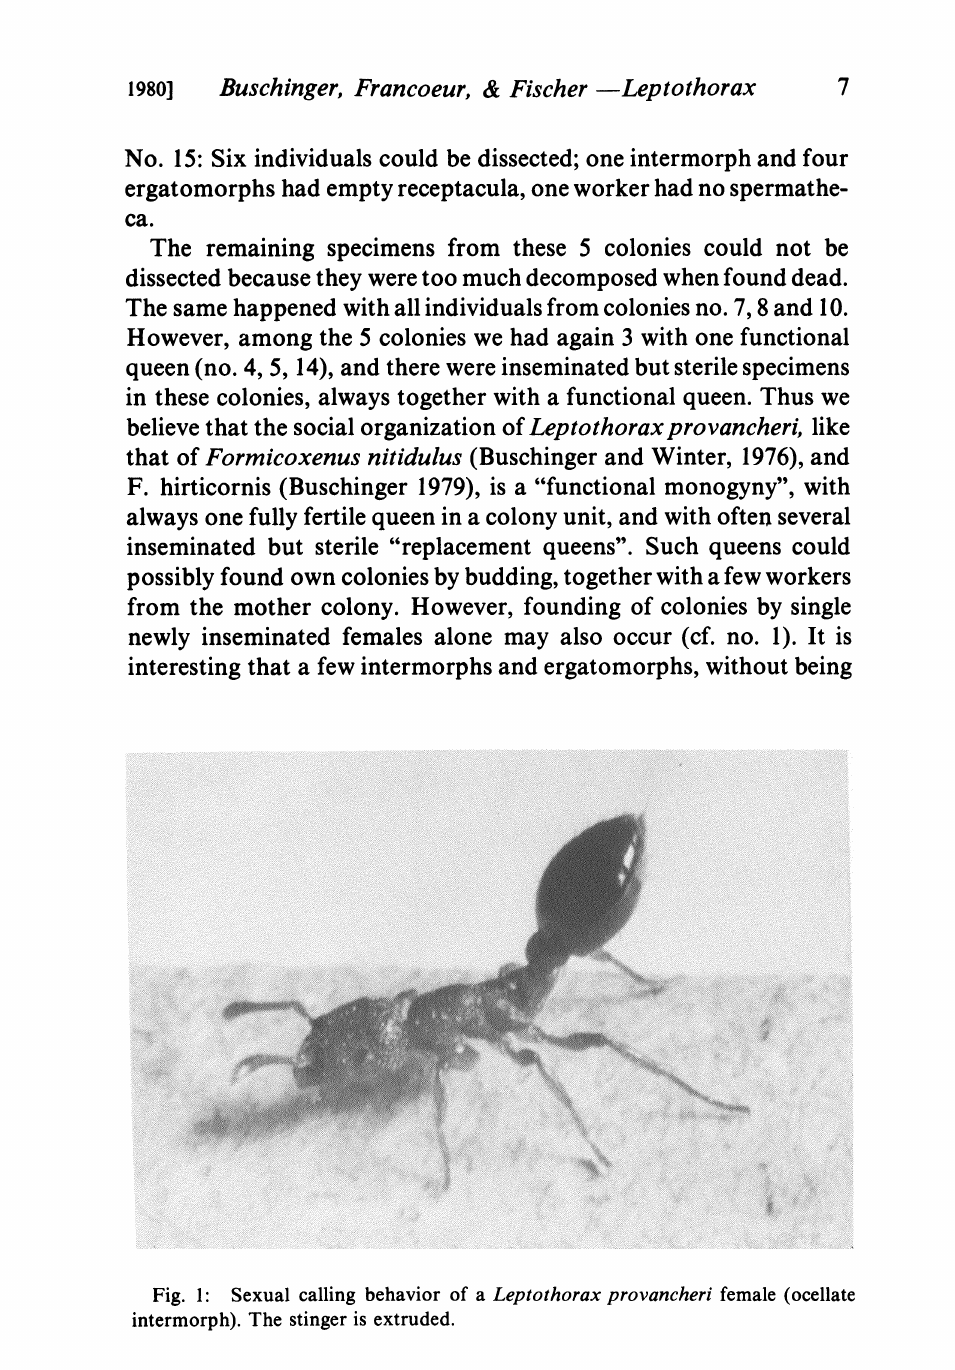
Fig. l: Sexual calling behavior of a Leptothorax provancheri female (oeellate intermorph). The stinger is